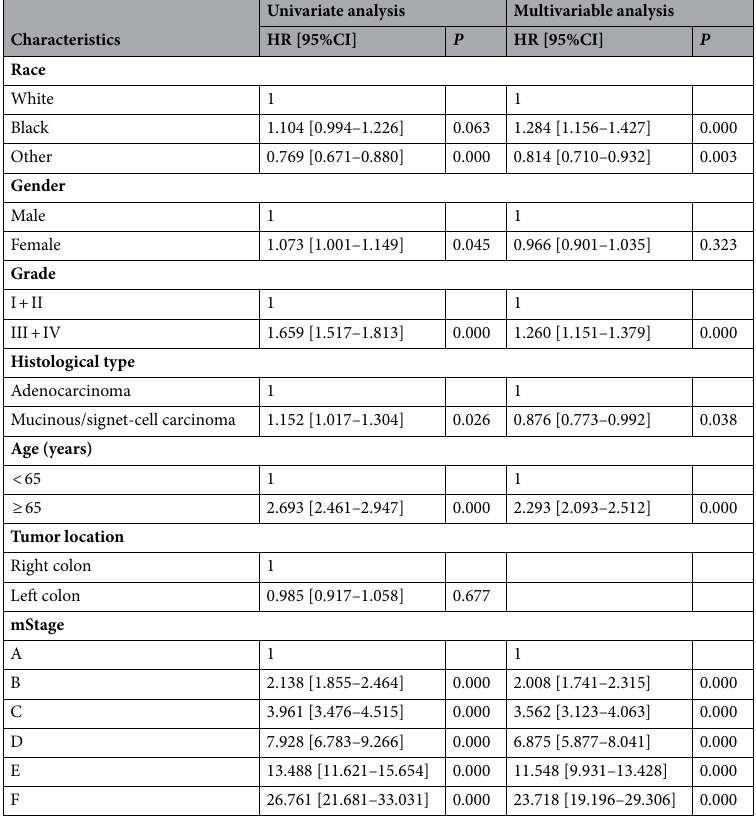
Table 4. Cox regression analyses of factors related to CSS in the development cohort.